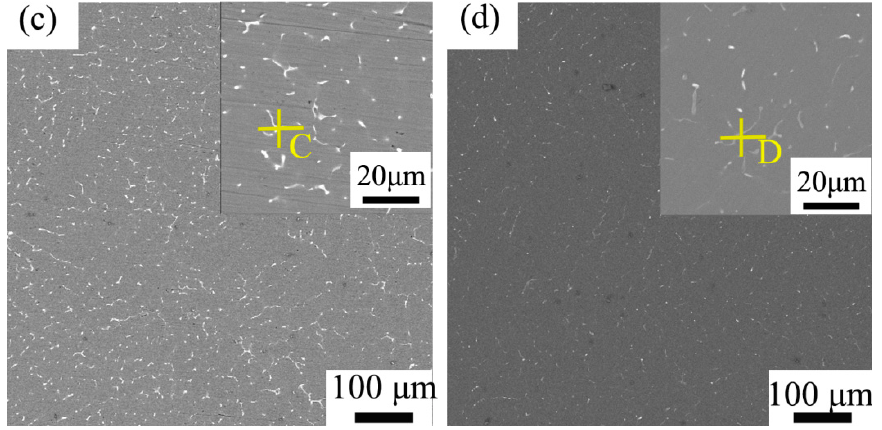
Figure 1. SEM images of the as-cast alloys: ( a ) alloy 1, ( b ) alloy 2, ( c ) alloy 3, and ( d ) alloy 4. A–D are point EDS of the second phases. Table 2. EDS analysis of the second phases in as-cast Mg-2Al-0.5Ca-xZn alloys (at %).